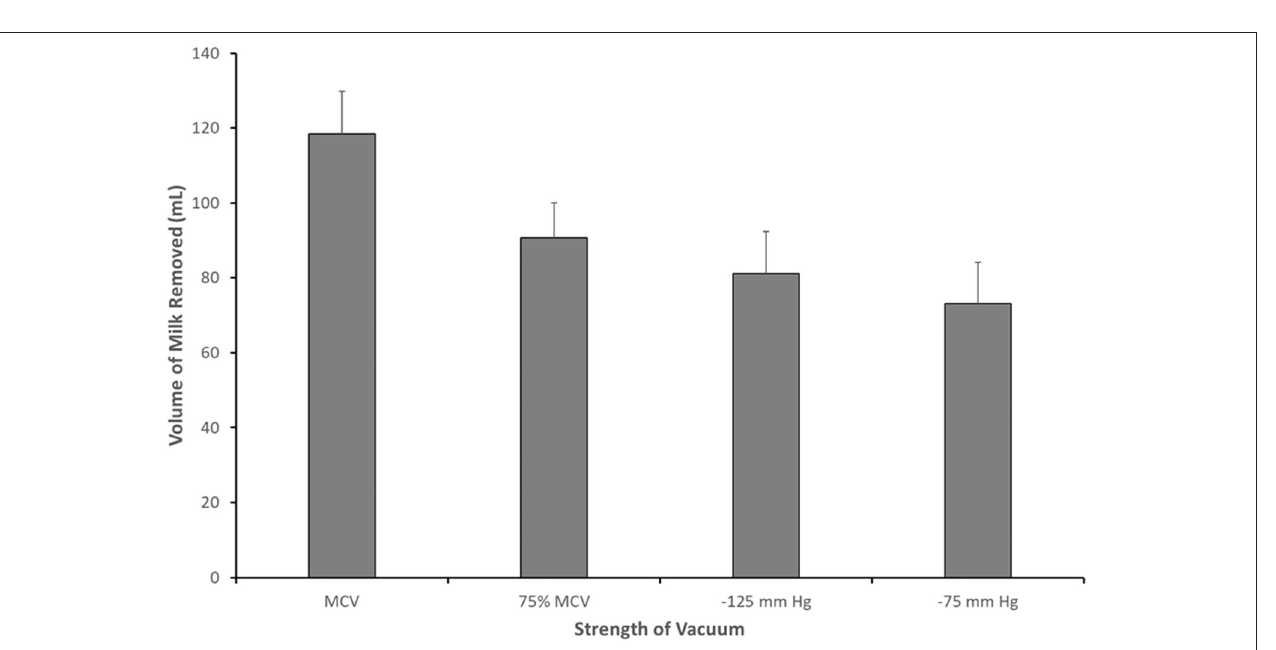
strategy of the conservative management approach (4, 15,